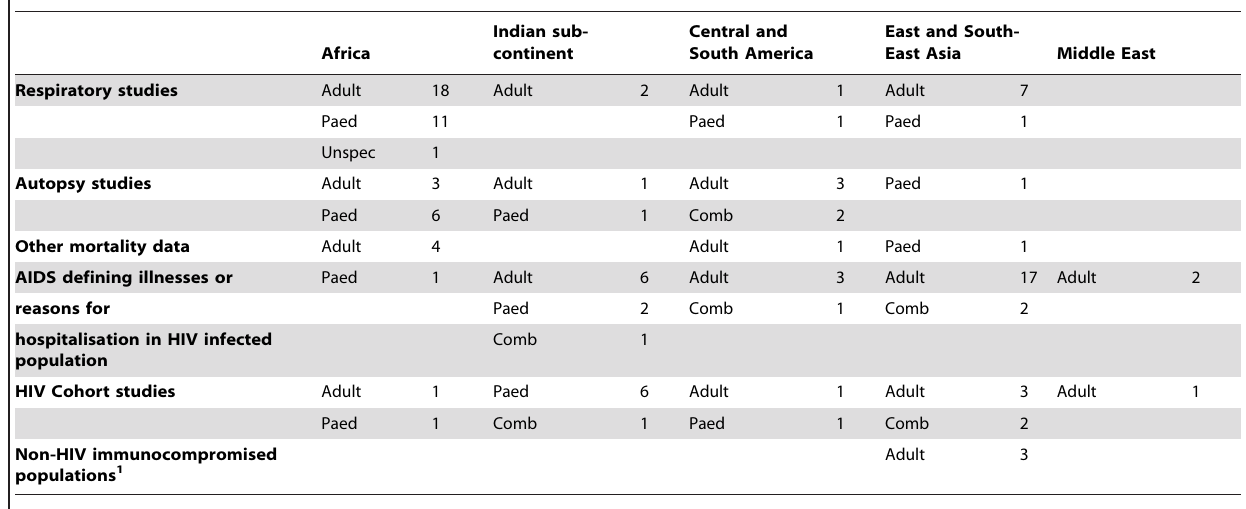
Table 3. Classification of reviewed studies.